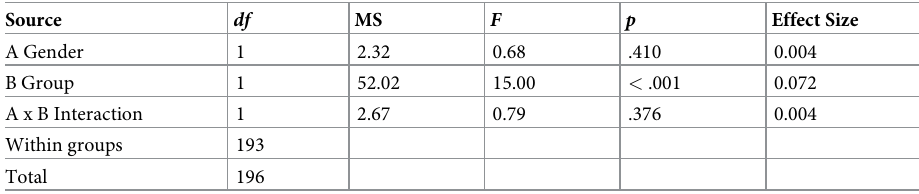
Table 14. ANOVA summary table for wellbeing.